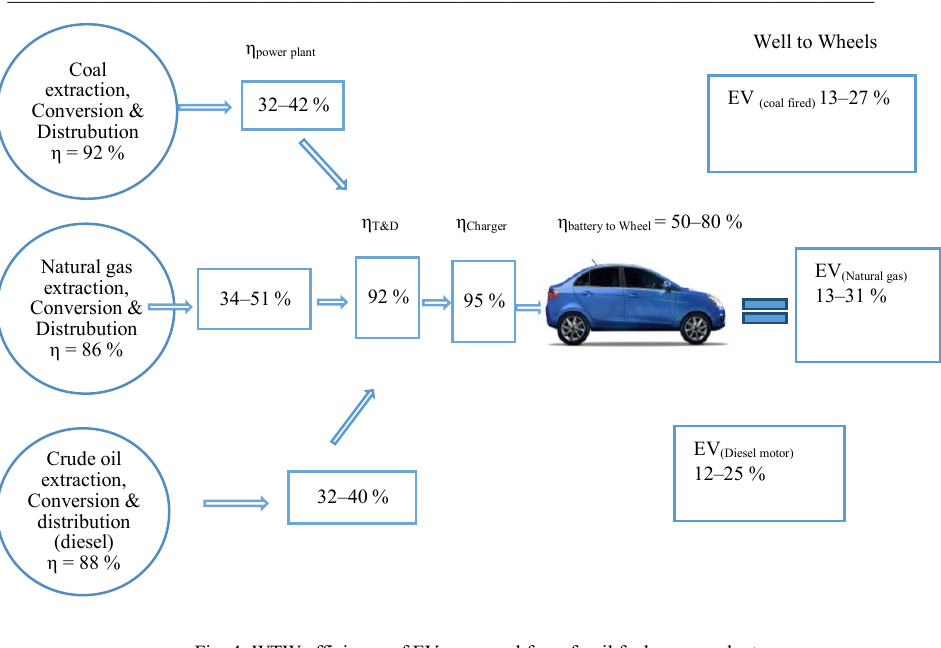
Fig. 4. WTW efficiency of EVs powered from fossil fuels power plants.